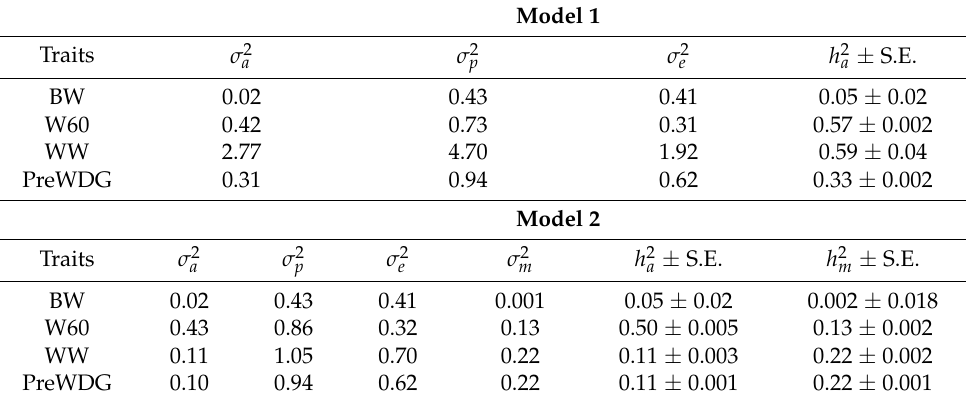
Table 3. Variance components and heritability values of growth traits.